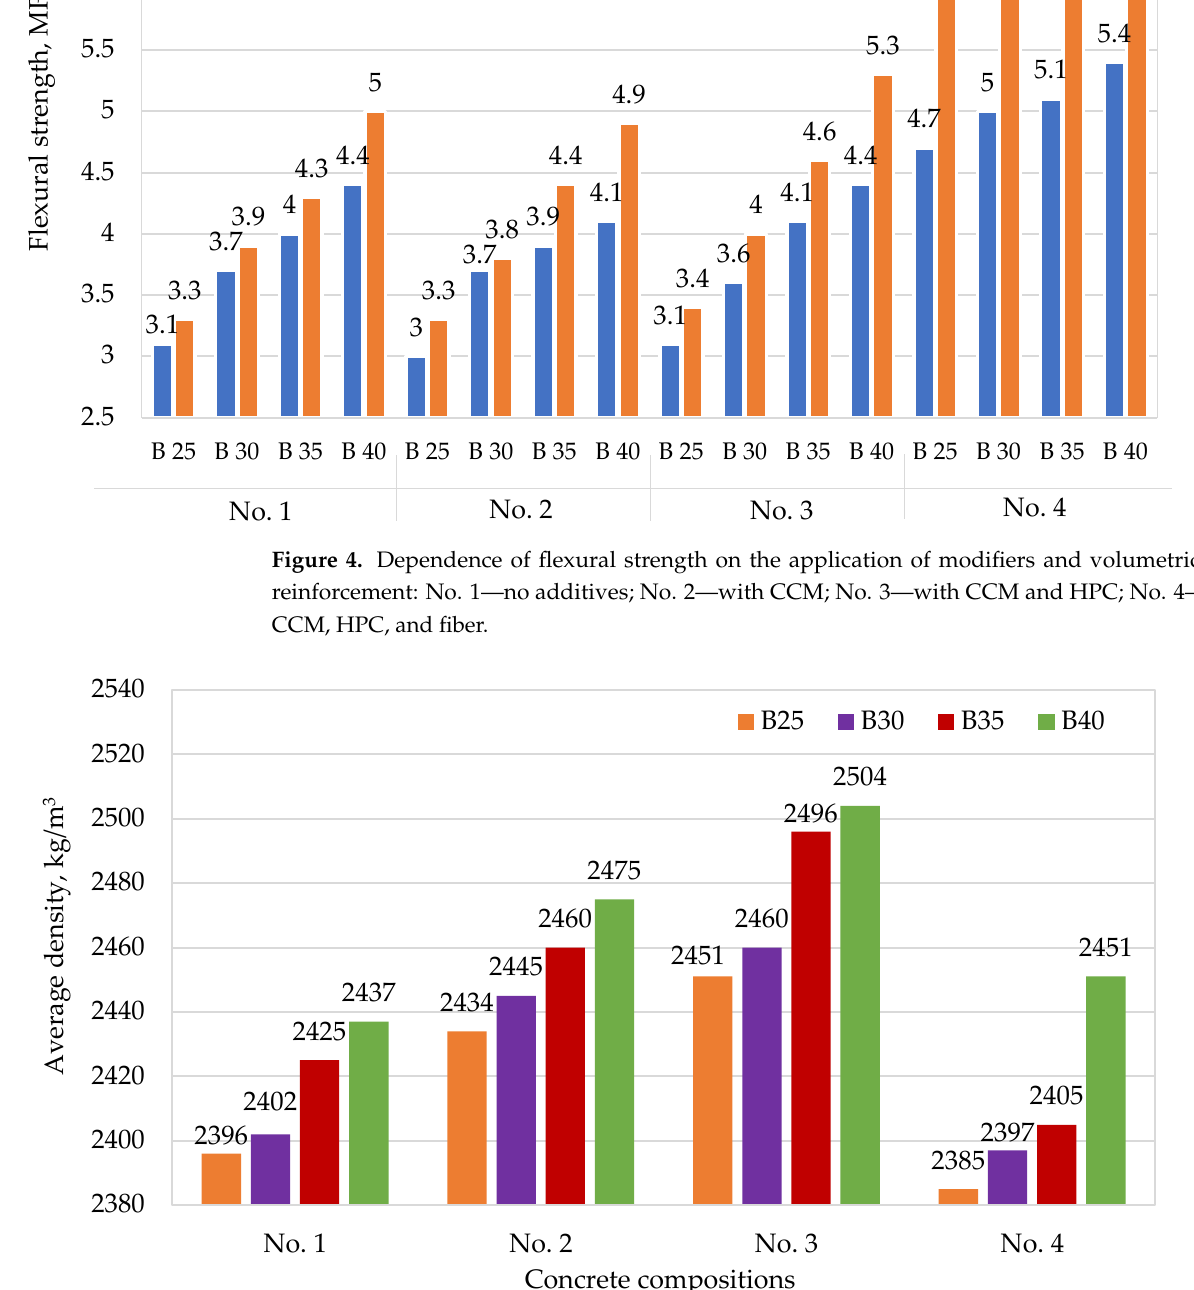
Figure 5. Dependence of concrete density on the application of modifiers and volumetric fiber rein- forcement: No. 1—no additives; No. 2—with CCM; No. 3—with CCM and HPC; No. 4—with CCM, HPC, and fiber.